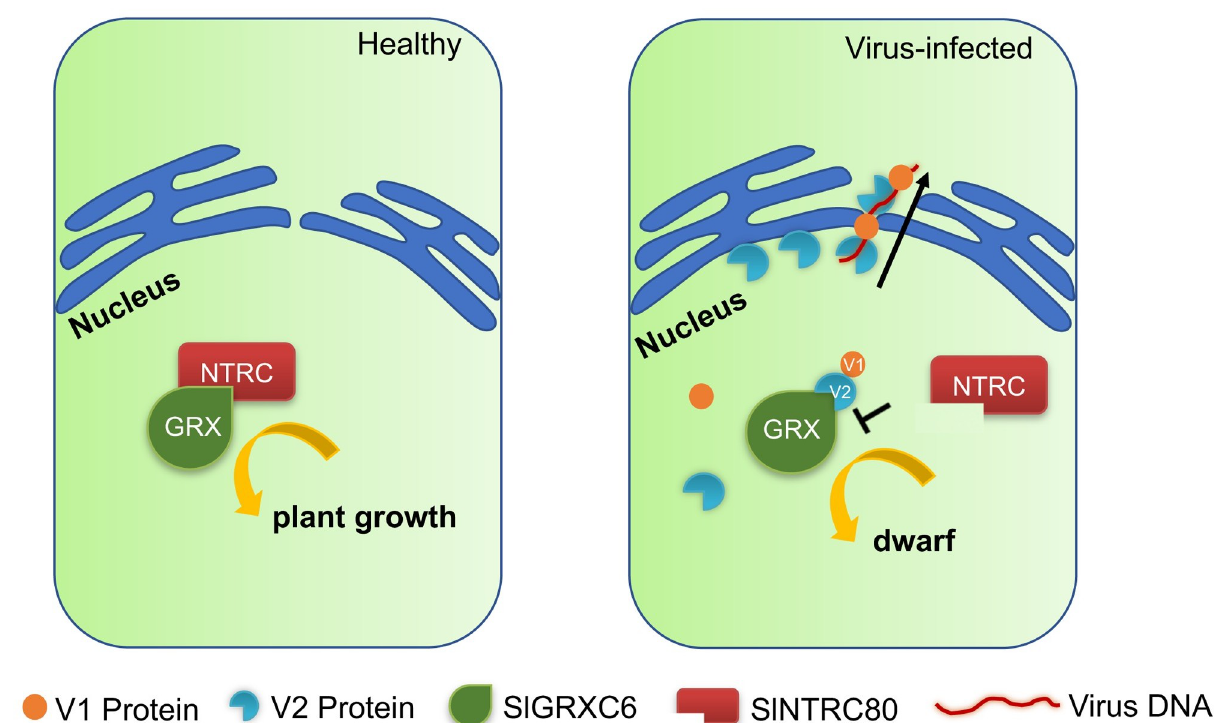
Fig 7. A proposed model for possible roles of the SlGRXC6-V2 interaction in the regulation of plant growth and the restriction of TYLCV infection. SlGRXC6 and SlNTRC80 physically interact and are cooperatively involved in regulating plant growth. Disruption of the interactions or the balance between them leads to growth defects. The TYLCV V2 protein is a symptom determinant and interacts with SlGRXC6 during viral infection. The V2-SlGRXC6 interaction inhibits or slows down the nuclear export of V2, the V2-mediated nuclear export of V1, and the V1-viral DNA complex, and therefore, restricts viral infection. The V2-SlGRXC6 interaction also sequesters SlGRXC6 from binding to SlNTRC80, interfering the SlNTRC80-SlGRXC6 interaction and leading to growth